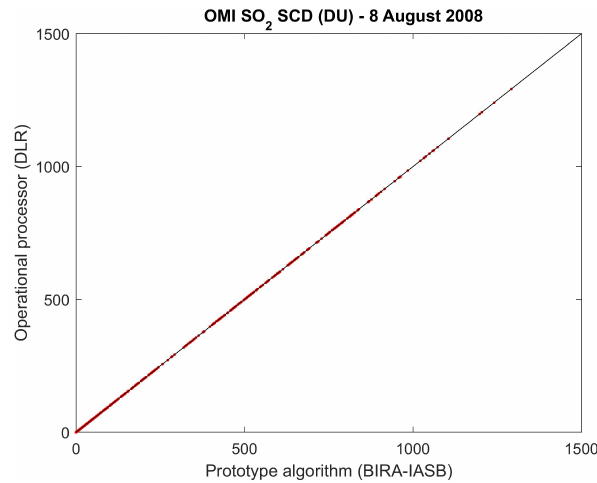
Figure 11. Comparison of SO 2 SCDs between prototype algorithm and operational processor for the OMI test data of 8 August 2008.